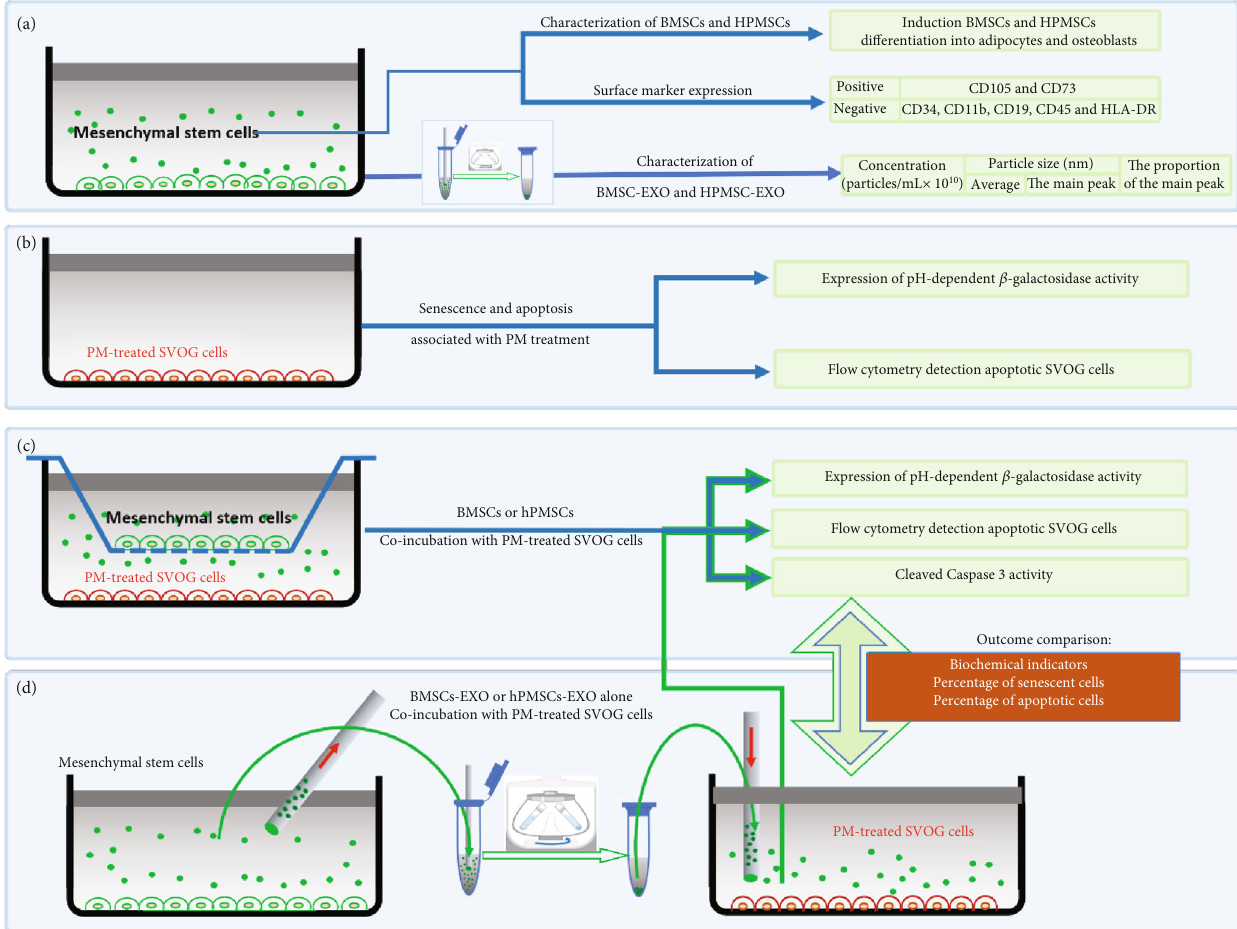
Figure 1: Schematic design of this experiment. (a) The characterization of BMSCs and HPMSCs. The separation and characterization of BMSC-EXO and HPMSC-EXO. (b) Senescence and apoptosis associated with PM-treated SVOG cells. (c) BMSCs or HPMSCs coincubation with PM-treated SVOG cells. (d) BMSCs-EXO or HPMSCs-EXO alone coincubation with PM-treated SVOG